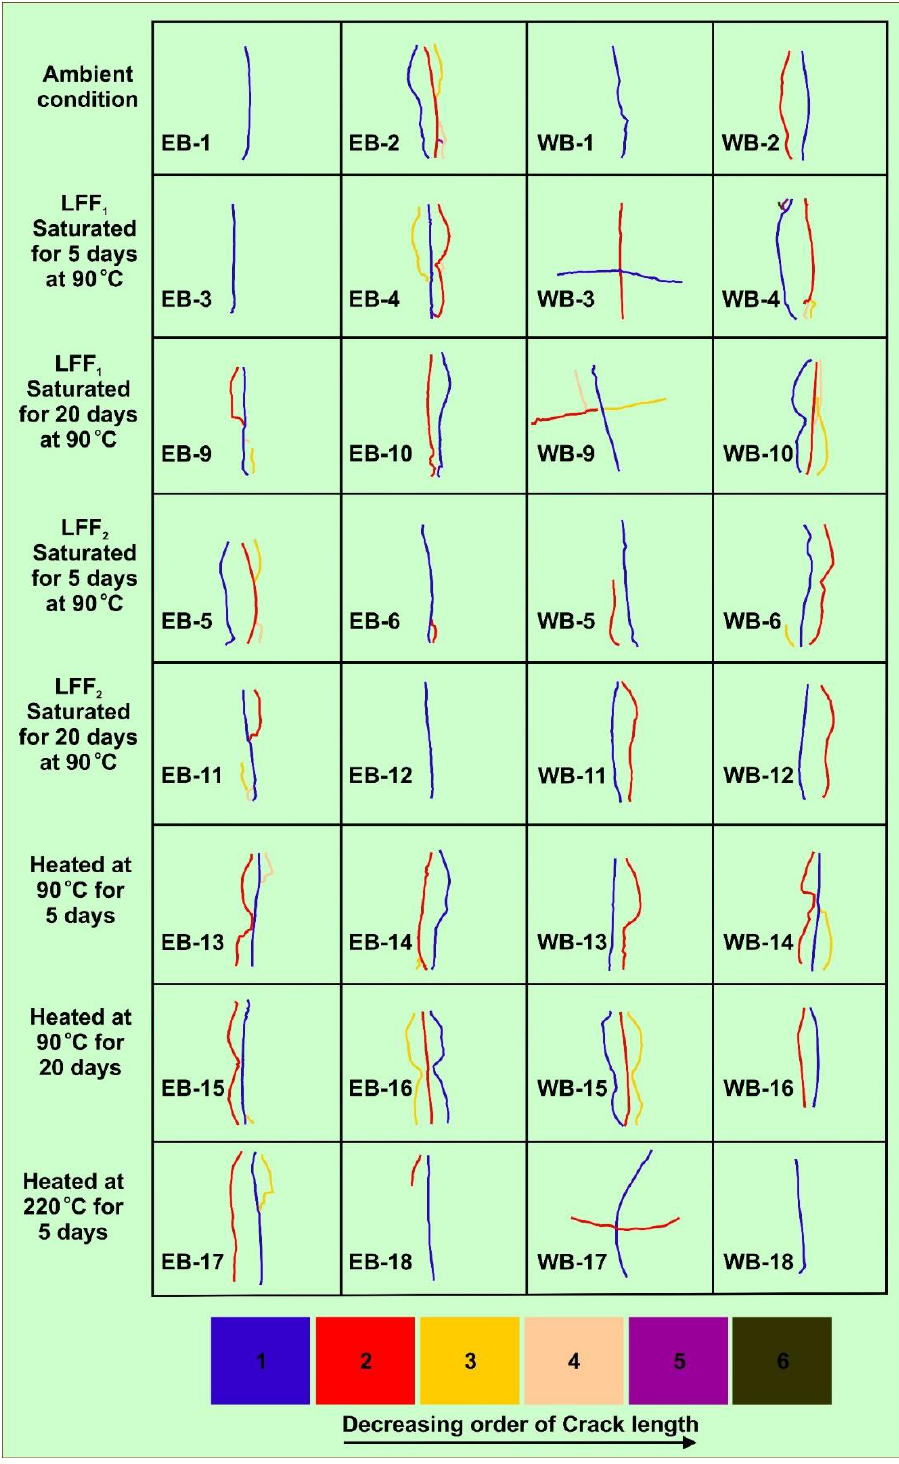
Figure 23. Traces of crack/fracture patterns resulting from various sample sets (ambient, thermally conditioned LFF 1 & 2 saturated, and heat treated at 90 and 220 °C) at post BITS testing, and these traces were used in sample surface crack length